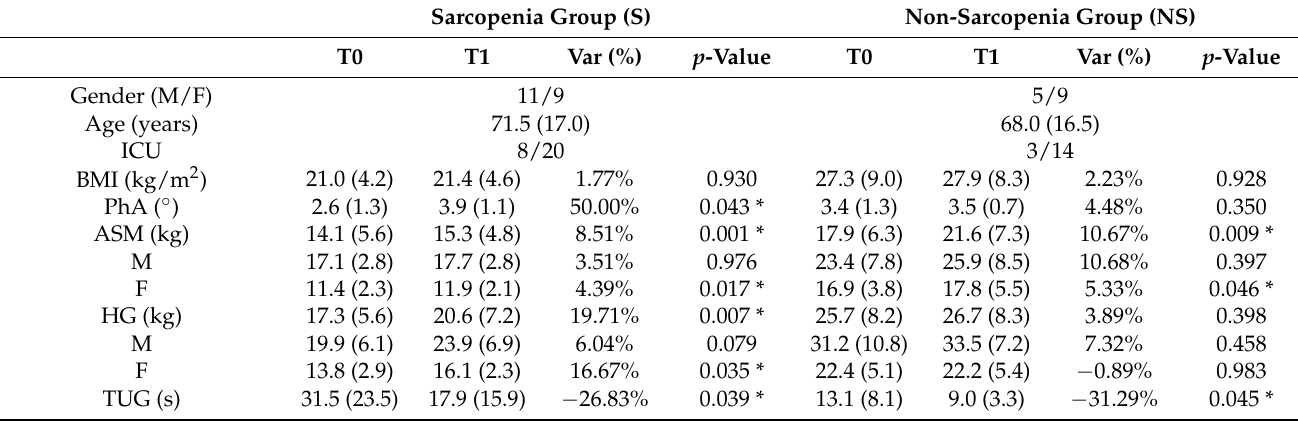
Table 1. ICU stay in previous hospitalization, anthropometric, body composition (PhA, ASM), muscle strength (handgrip) and functional (TUG) parameters at T0 and T1 in both the sarcopenia group (S) and non-sarcopenia group (NS) for males (M) and females (F). All data are reported as mean ± standard deviation (SD).